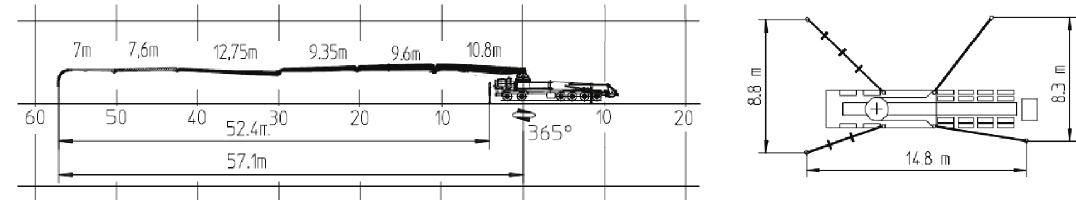
Fig. 8. Selected characteristics of the vehicle-mounted pump for concrete mix Putzmeister 6RZ62 [own study, on the basis of